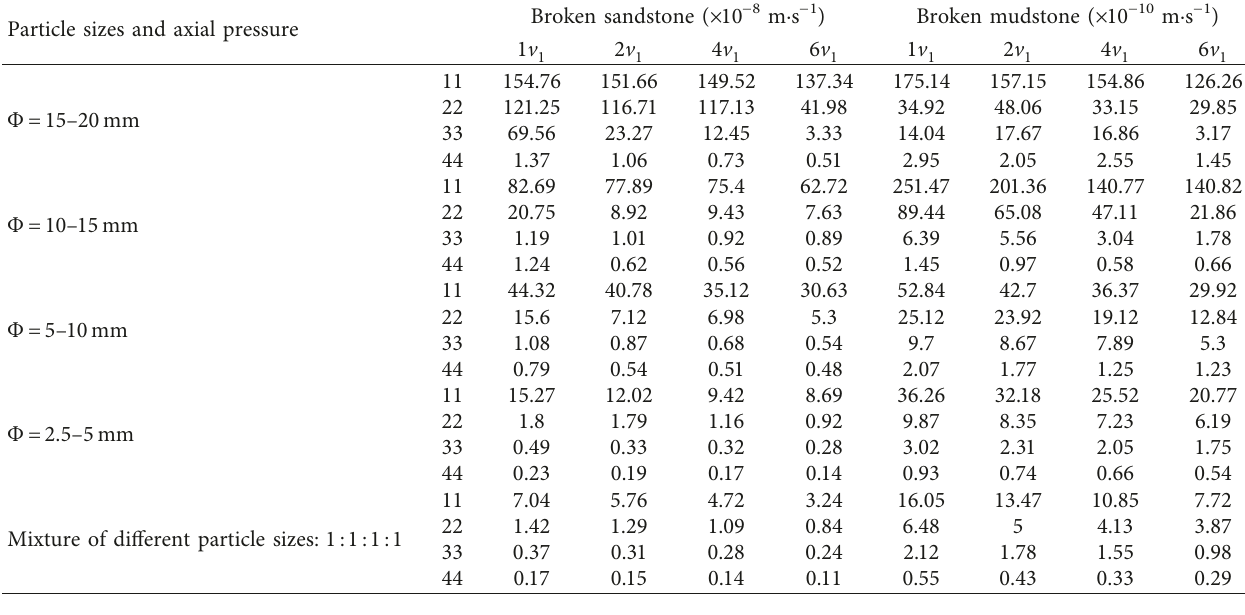
Table 1: Permeability coefficients of broken sandstone and broken mudstone/ v Particle sizes and axial pressure